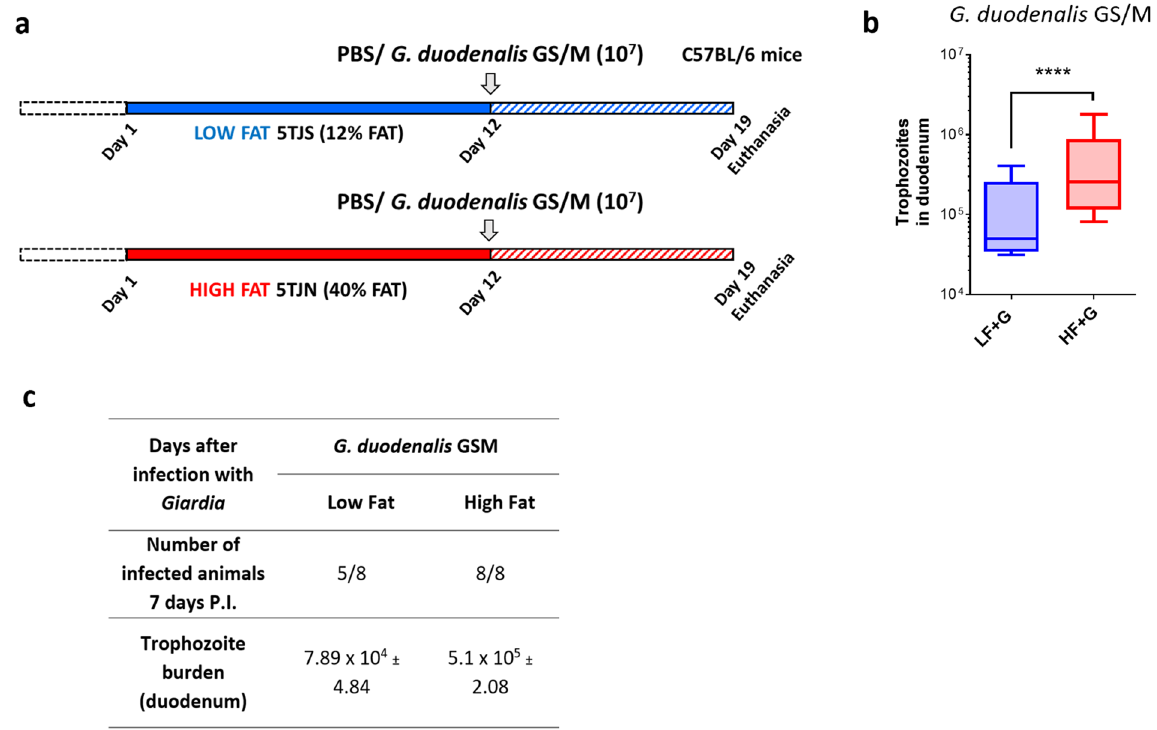
Figure 1. High fat diet increases host susceptibility to Giardia infection in C57BL/6 mice. ( a ) Experimental design (experimental condition #1). C57BL/6 mice (3–4-week-old) received either a low fat (LF) or a high fat (HF) diet for 12 days and were infected with G. duodenalis isolate GS/M (1 × 10 7 trophozoites) at day 12. Control animals received PBS. Animals were euthanized at 7 days post-infection (day 19). ( b ) Duodenal G. duodenalis trophozoite burden was assessed at 7 days PI. Trophozoite burden was higher in HF + G mice compared with LF + G mice. No trophozoites were detected in the PBS group. ( c ) Number of infected animals per experimental group at 7 days PI. LF + G = low fat infected mice; HF + G = high fat infected mice. Data are representative of 8 mice/group and are shown as box plots with min/max whiskers; **** p <